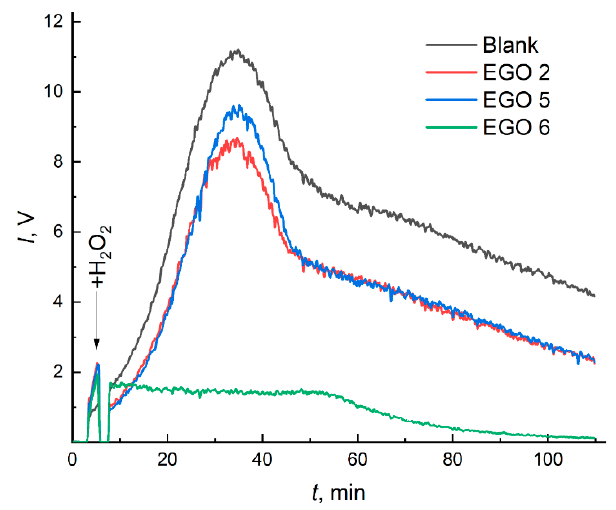
Figure 8. Chemiluminograms of EGO aqueous dispersions in the CL system: EGO 2, two-step synthesized samples of EGO with a separated cathode–anode compartment with additional current treatment and a platinum rod as an anode (procedure 3, c EGO = 16.0 ± 2.0 ppm); EGO 5, one-step synthesized samples of EGO with a separated cathode–anode compartment without further current treatment (procedure 5, c EGO = 15.2 ± 1.8 ppm); and EGO 6, one-step synthesized samples of EGO with a combined cathode–anode compartment (procedure 6, c EGO = 16.8 ± 2.5 ppm). The CL system contained luminol (100 µ L, 1 mM), Co(II) (65 µ L, 1 mM), and H 2 O 2 (40 µ L, 1100 mM). The tested systems were spiked with 200 µ L of each EGO